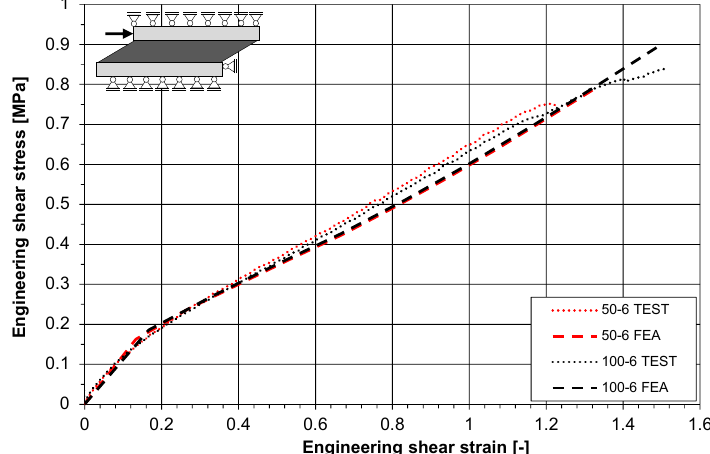
Fig. 20 Experimental and numerical results of the engineering stress-strain curve in shear for the specimen of 6 mm